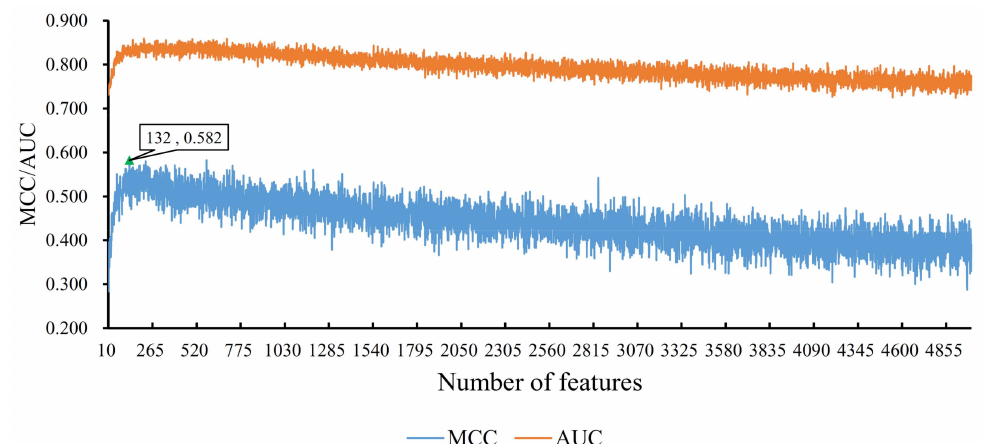
Figure 5. IFS curves derived from the IFS method and RF algorithm. X -axis is the number of features participating in building classifiers in feature subsets. Y -axis is their corresponding MCC or AUC values. When first 132 features in feature list were considered, the optimal MCC value reached 0.582, which is marked by a triangle.